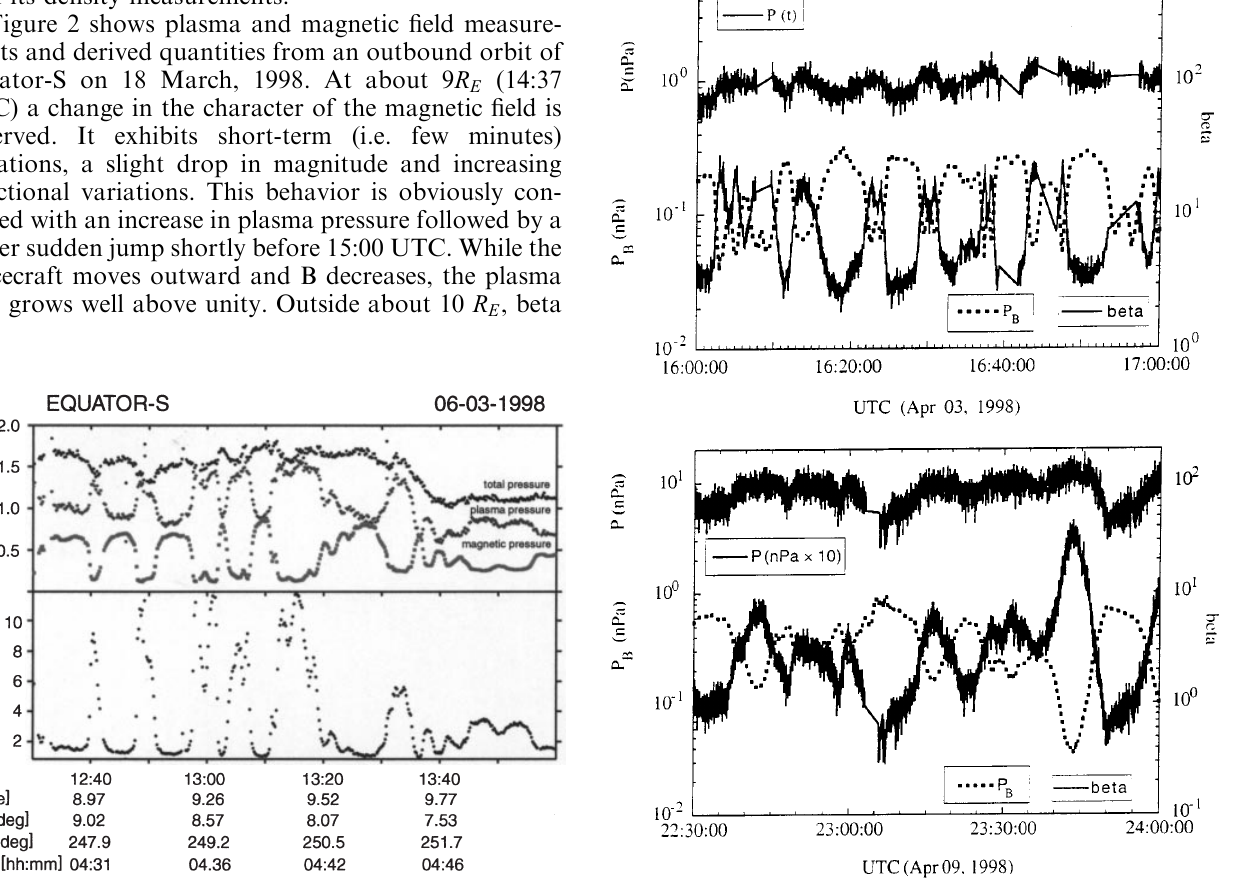
Fig. 2. Plasma and magnetic-field measurements plus derived quan- tities on an outbound orbit of Equator-S on 18 March 1998. Outside about 10 R E , large-amplitude variations of magnetic field strength and orientation are found in a high-beta environment